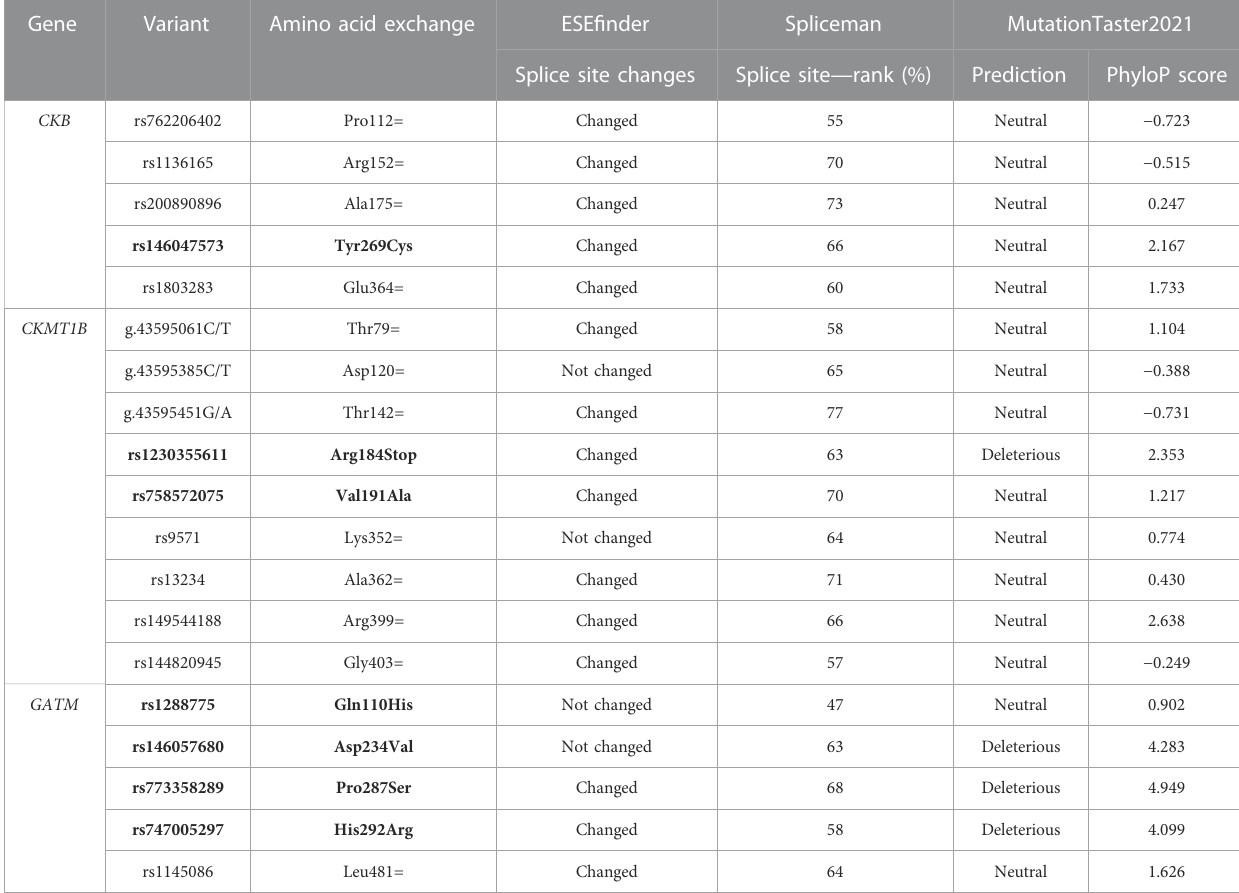
TABLE 4 In silico predictions of splice site alterations and pathogenicity of the detected variants in CKB , CKMT1B, and GATM . To analyze the putative effects of variants onsplicingproducts,thetoolsESE fi nder(Cartegnietal.,2003)andSpliceman (LimandFairbrother,2012)wereapplied.Predictions ofpathogenicityand a conservation score were obtained by MutationTaster 2021 (Steinhaus et al., 2021). Non-synonymous variants are shown in